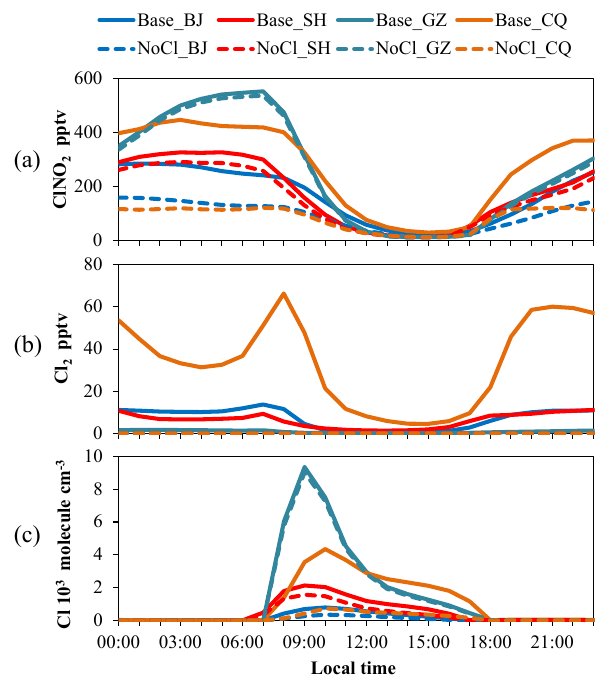
Figure 7. Diurnal variations of monthly mean concentrations of ClNO 2 (a) , Cl 2 (b) , and Cl radicals (c) in Beijing, Shanghai, Guangzhou, and Chongqing in the Base and NoCl